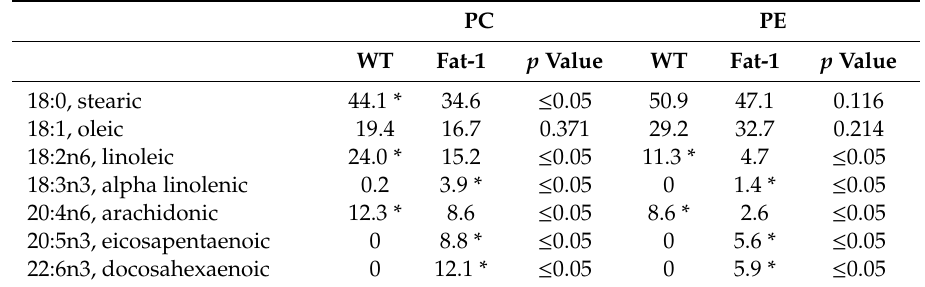
Table 2. Percent fatty acid composition of caveolae isolated from mammary epithelial cells of wildtype (WT) and fat-1 mice: PC and PE phospholipid fractions 1